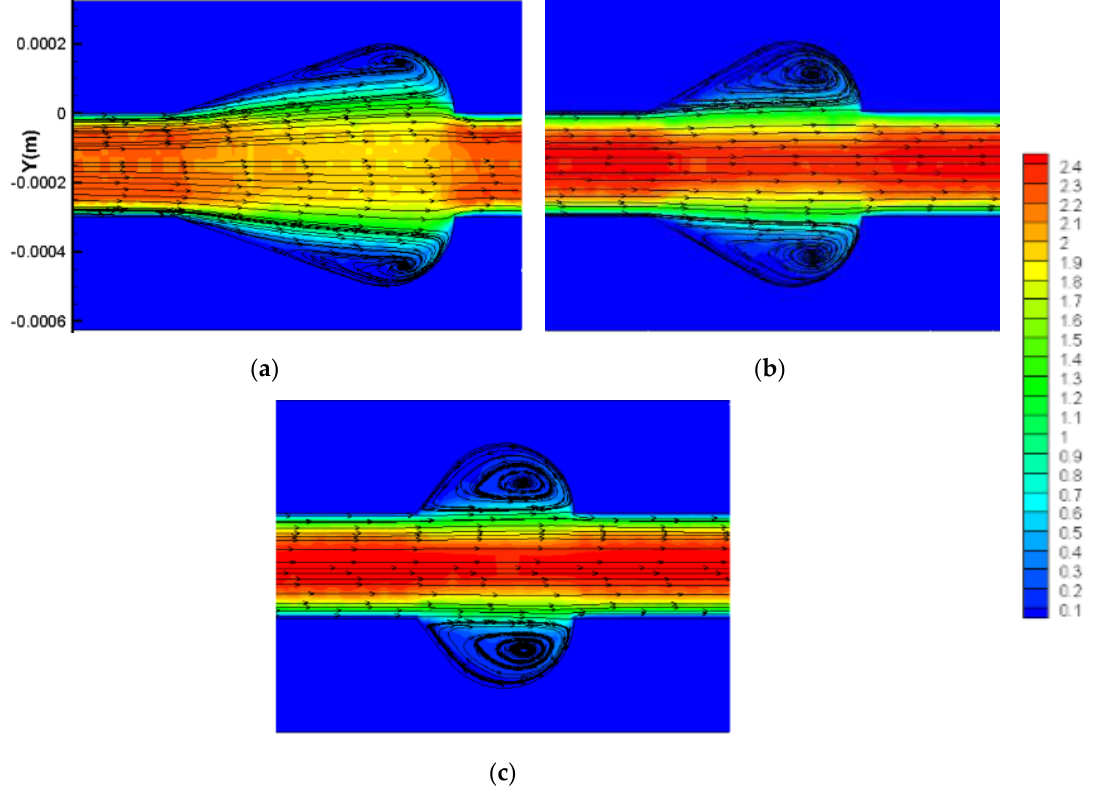
Figure 16. Velocity and streamline distribution in cavities with di ff erent α . ( a ) α = 0.25, ( b ) α = 0.33, and ( c ) α = 0.44